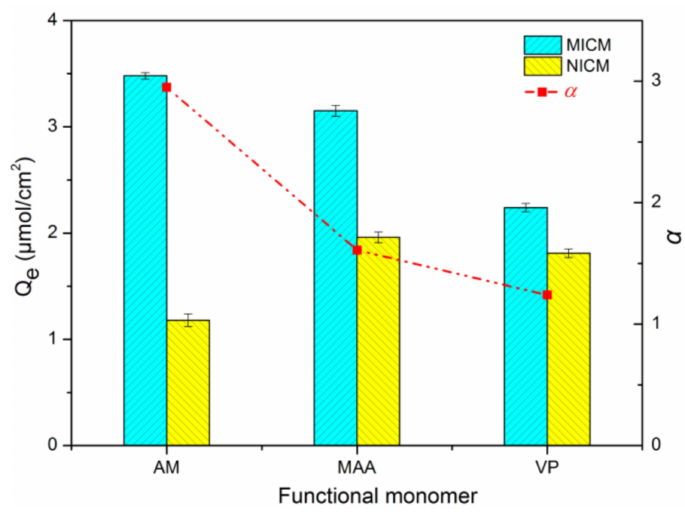
Figure 2. Effect of monomer species on adsorption capacity and imprinting factor of ECB.